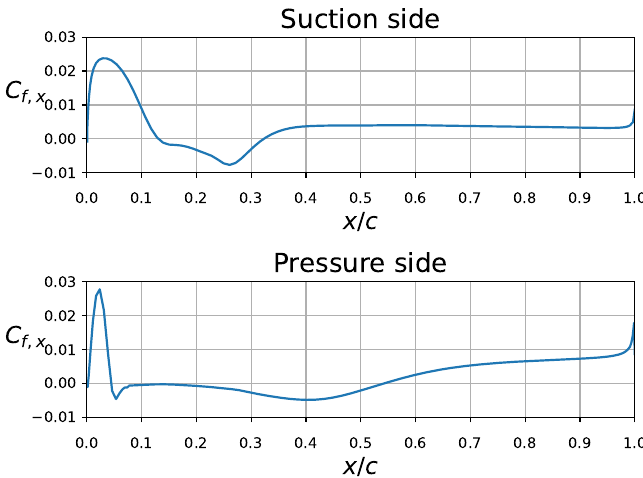
Figure 14. Chordwise C f , x distribution at the symmetry plane for Re = 10 5 and α = 6 ◦